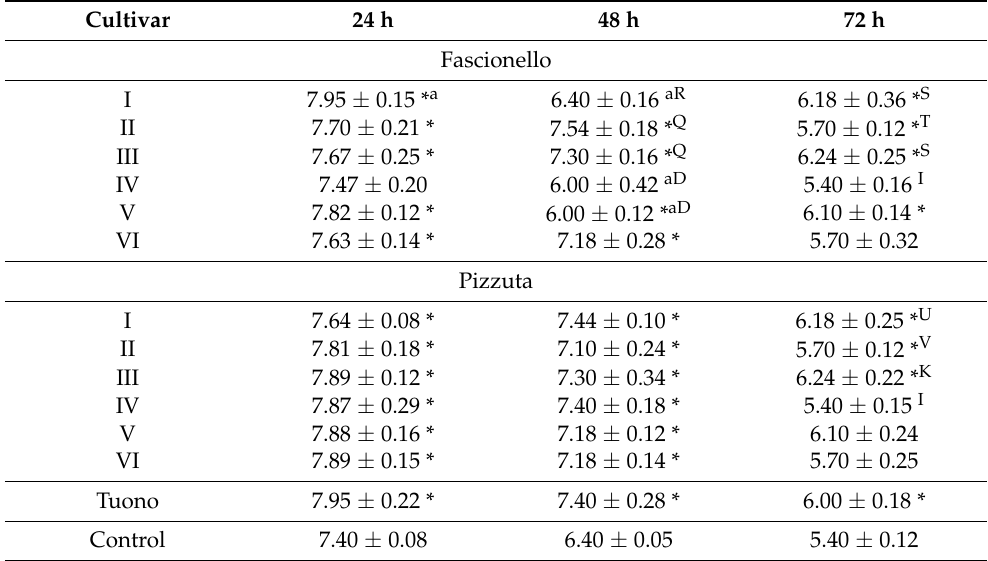
Table 7. Viability cell counts of Lactobacillus acidophilus (LA5) in media containing BS samples belonging to the three different cultivars (Fascionello, Pizzuta, and Tuono) and control during 72 h of fermentation. Results, which represent the average ± standard deviation of three independent experiments in triplicate ( n = 3), were expressed as log